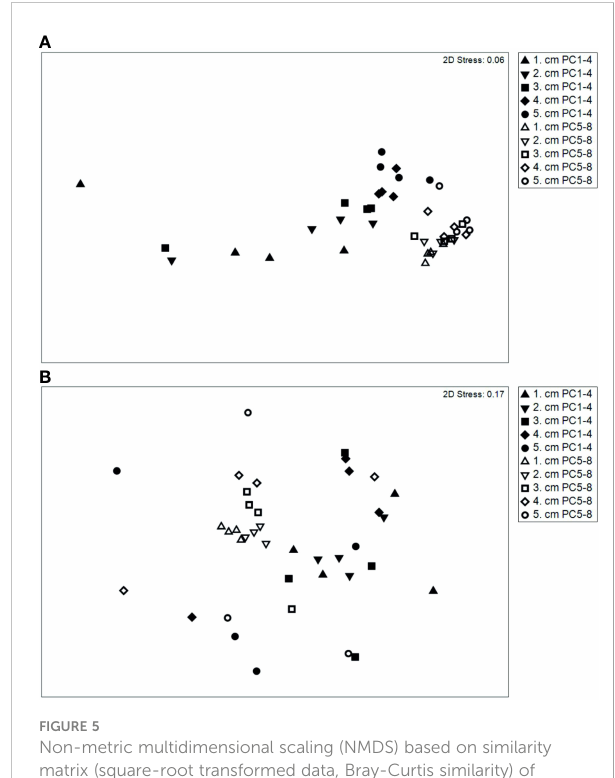
FIGURE 5 Non-metric multidimensional scaling (NMDS) based on similarity matrix (square-root transformed data, Bray-Curtis similarity) of bacteria (A) and nematode genera (B) abundance in iron-enriched (PC1-4) and unaffected (PC5-8)